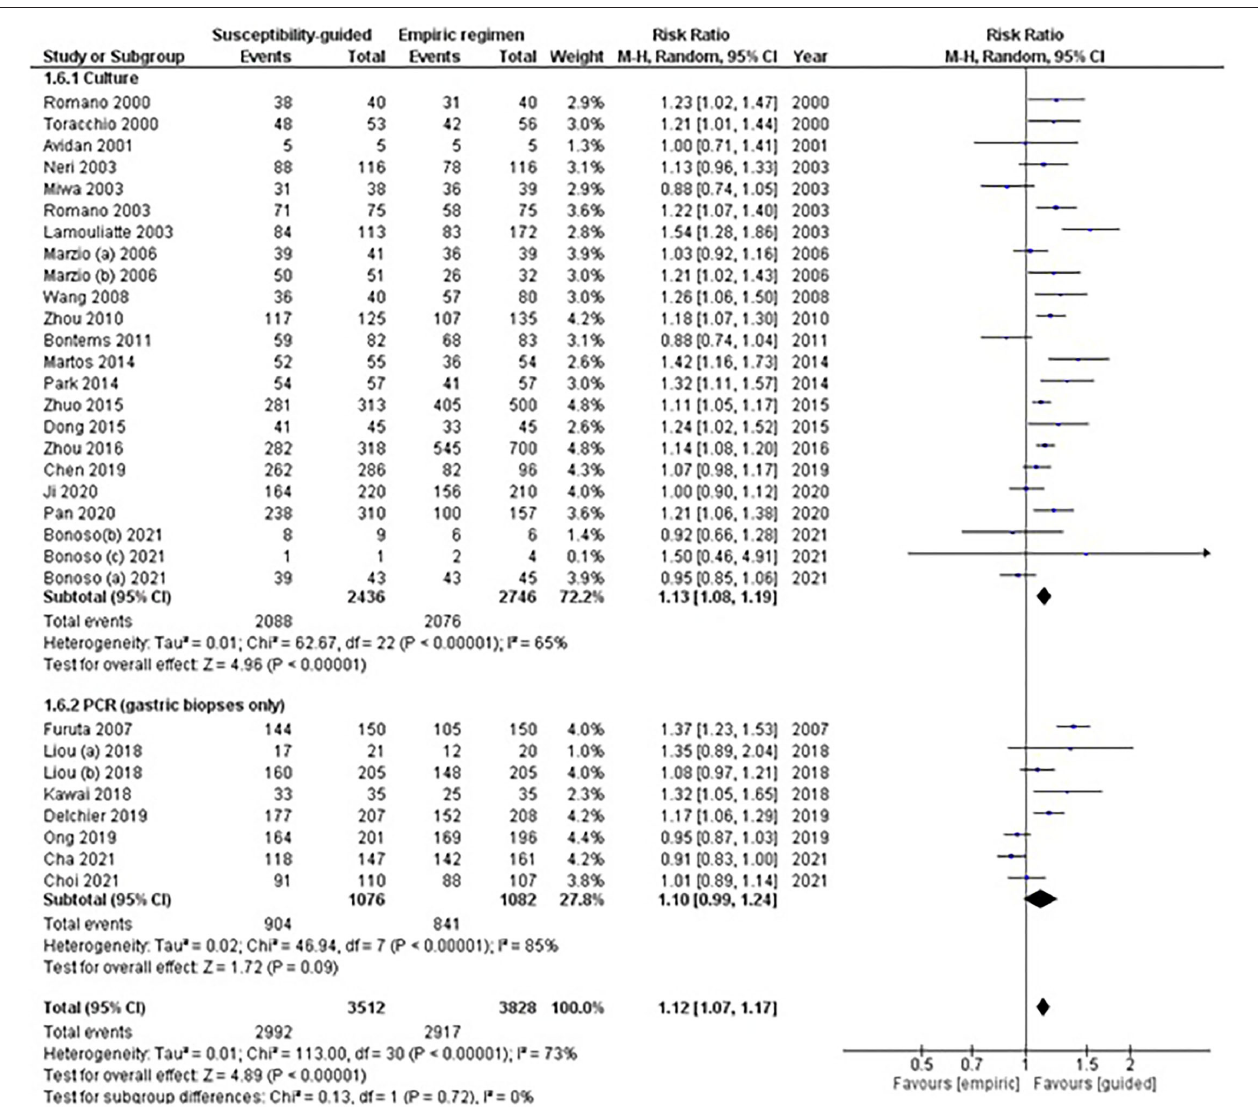
FIGURE 3 | Forest plot of randomized controlled studies comparing the effectiveness of susceptibility-guided and empirical treatment according to susceptibility method (culture vs. polymerase chain reaction). M-H, Mantel–Haenszel; CI, confidence interval; PCR, polymerase chain reaction.